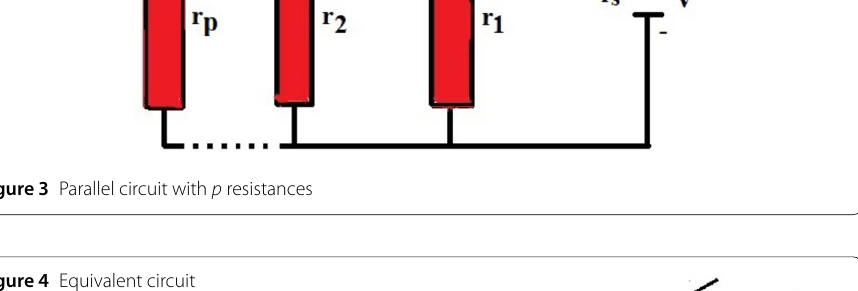
Figure 4 Equivalent